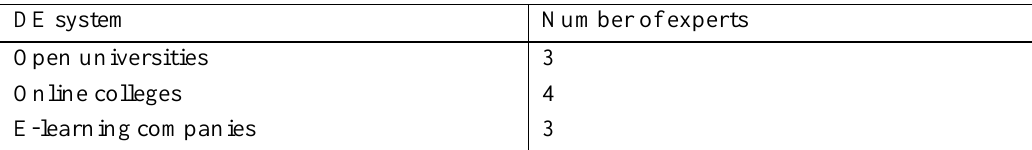
Expert Sampling from Different DE